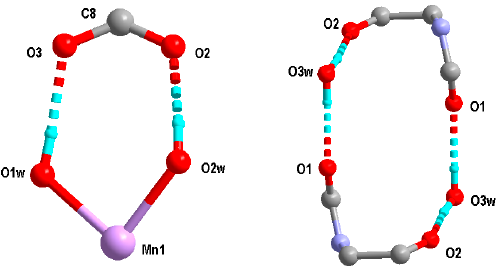
Figure 2. Two kinds of the element rings in the complex.